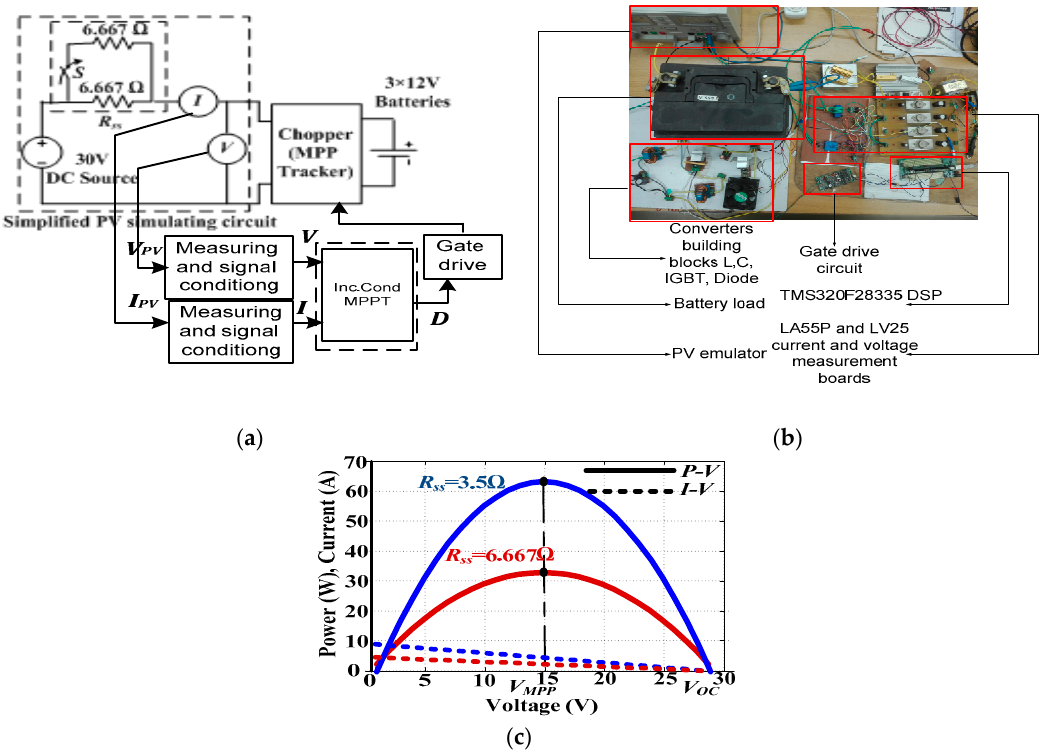
Figure 9. Experimental setup: ( a ) schematic diagram; ( b ) test rig photography, ( c ) PV emulator P-V, I-V curves. Energies 2019 , 12 , x FOR PEER REVIEW